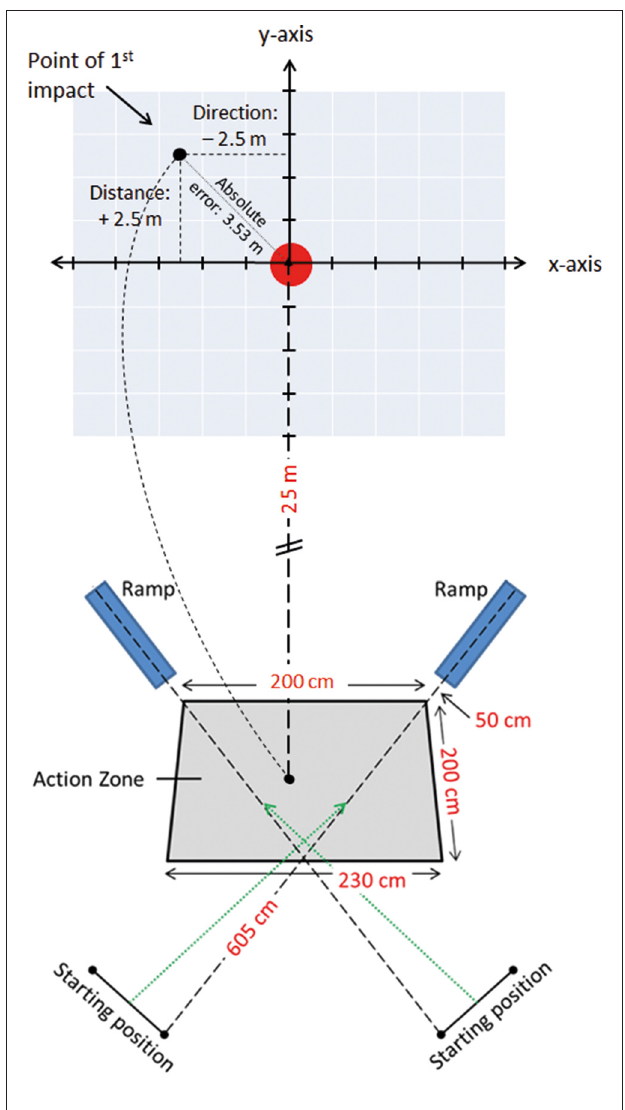
FIGURE 1 | Lay-out of the 25 m cross-pass task, with a schematic of the Cartesian coordinate system and the tarpaulin sheet with the printed target, the action-zone in which the cross-pass was performed, the position of the football delivery-ramps and the players’ starting positions.